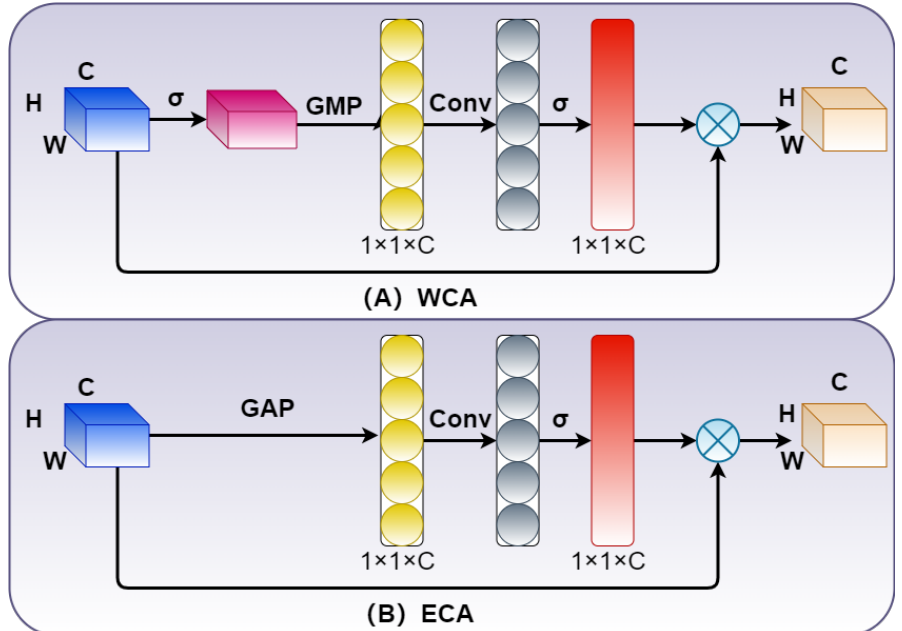
Figure 3. Difference between WCA and ECA. The WCA proposed by us is improved based on ECA. ECA can be better applied to large targets, but additional improvements are needed for small